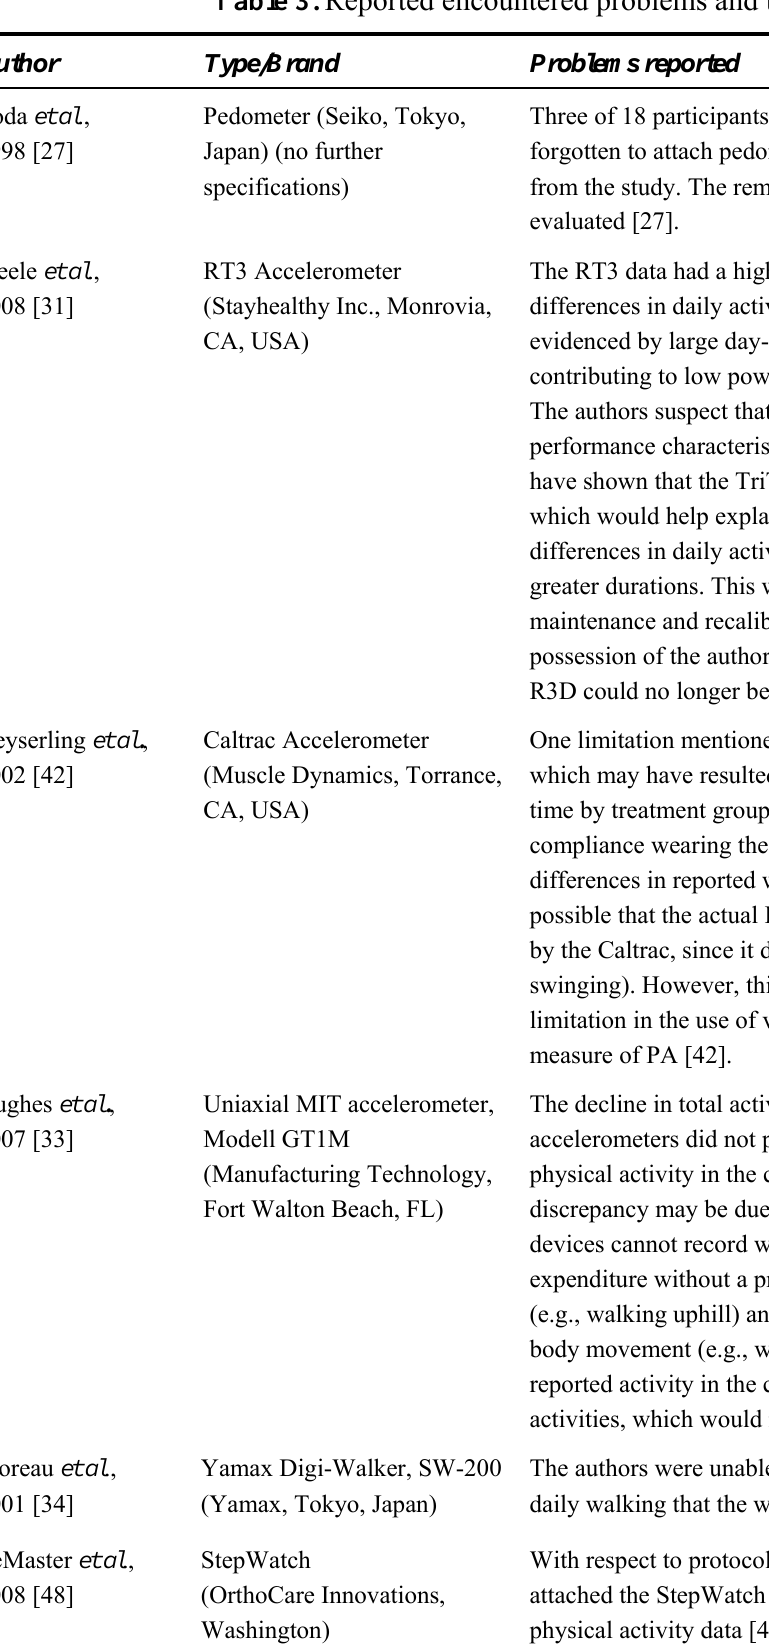
Table 3. Reported encountered problems and technical